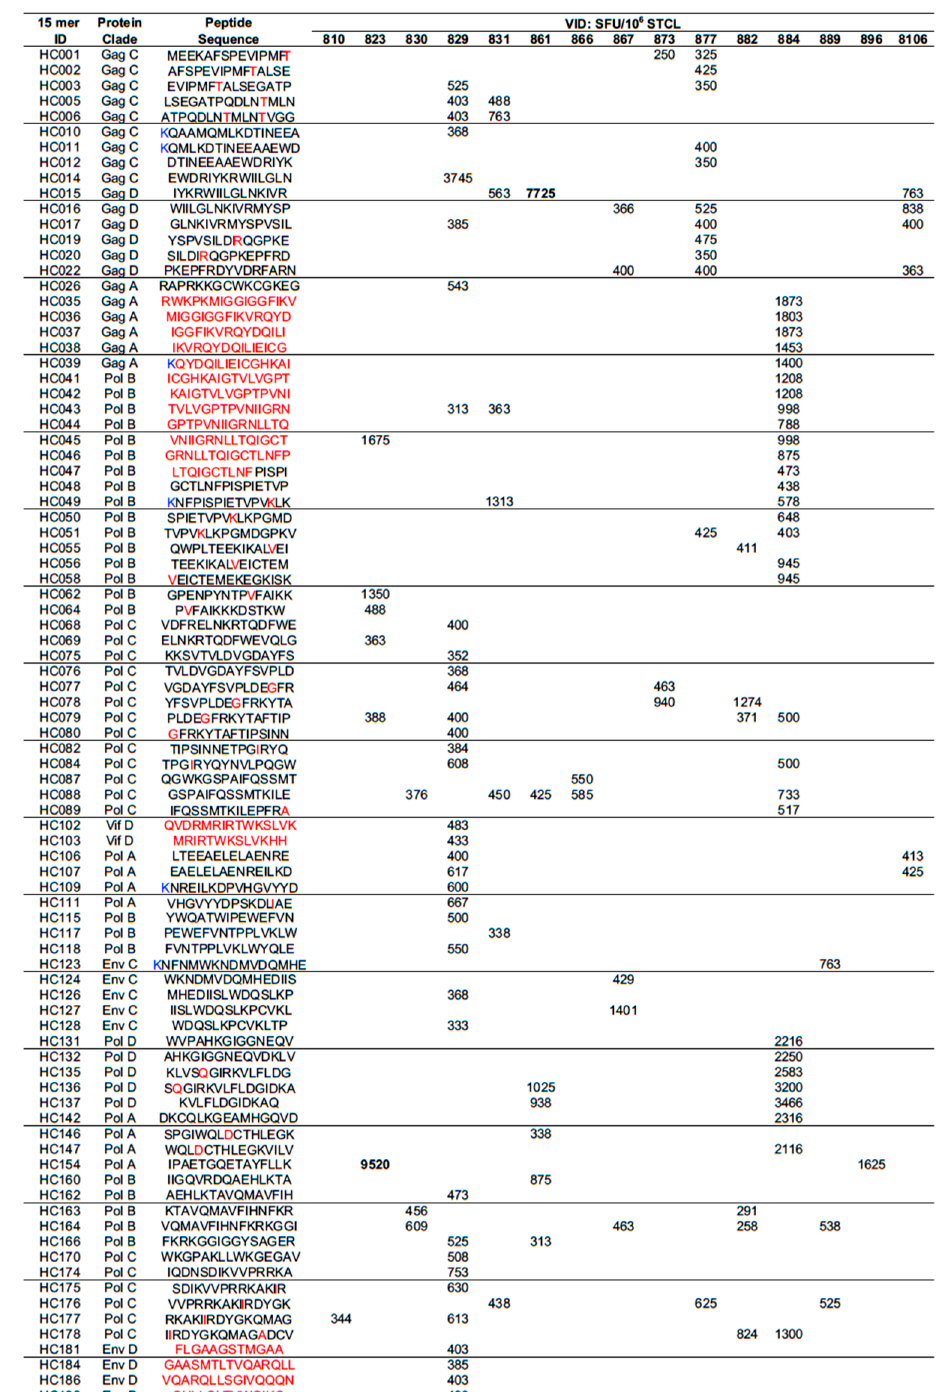
Figure 3. Mapping of stimulatory 15-mer peptides. PBMCs were expanded in vitro with 1 of 6 pools of overlapping 15/11 aa peptides spanning the entire HIVconsv immunogen for 10 days to establish short-term cell lines (STCL) and tested in an IFN- γ ELISPOT assay against individual peptides. The frequencies of responding IFN- γ SFU stimulated by peptides are indicated. Peptides and aa shown in red were present in HIVconsv and absent from GRIN. Terminal ‘K’ (blue) were added for solubility (non-HIV). VID—volunteer